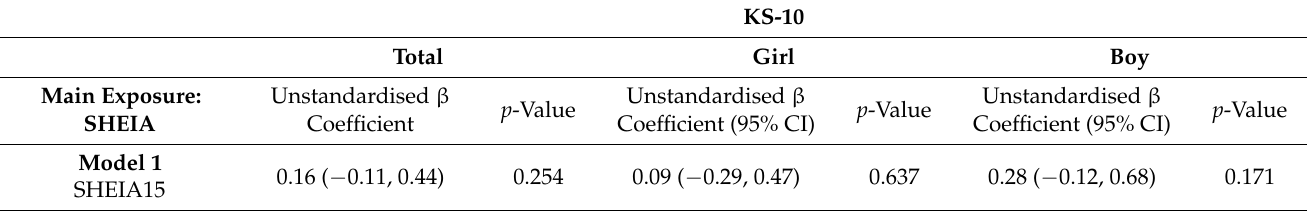
Table 2. Associations between SHEIA and KS-10 and between RADDS and